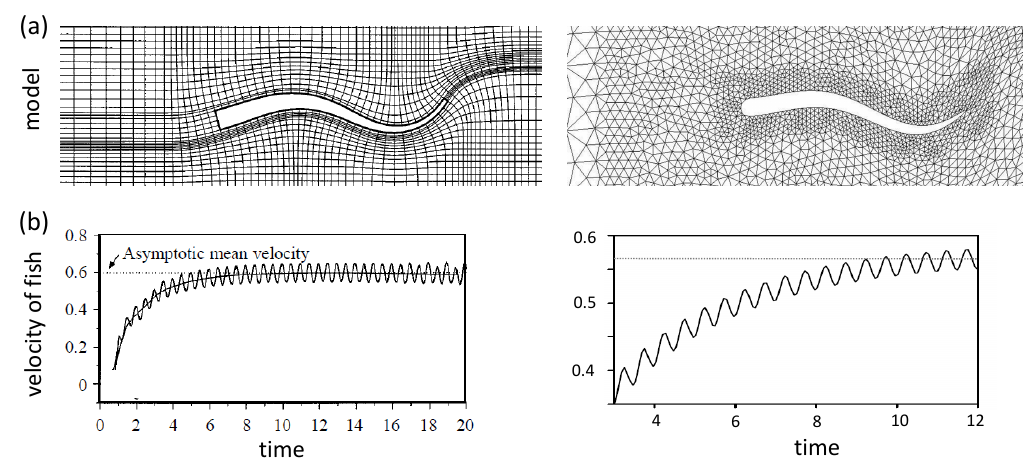
Figure 5. Result of method correctness analysis: ( a ) model, ( b ) image of velocity change with